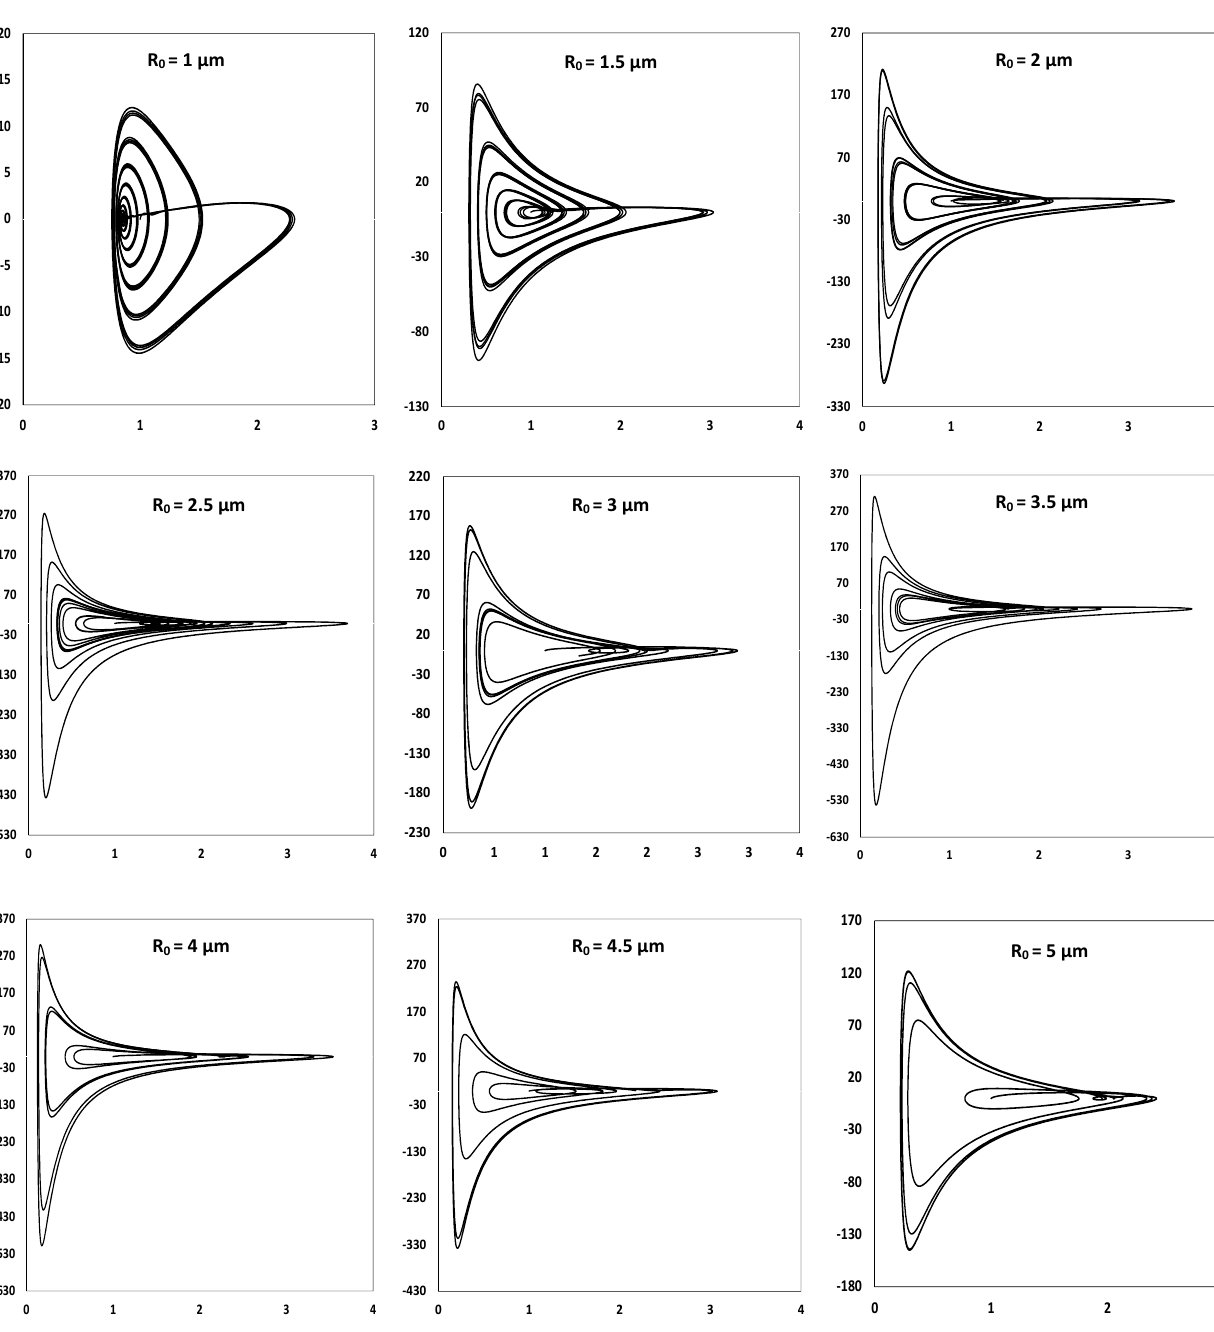
(horizontal axis) for acoustic bubbles R 0 (cid:2902) (cid:3116)